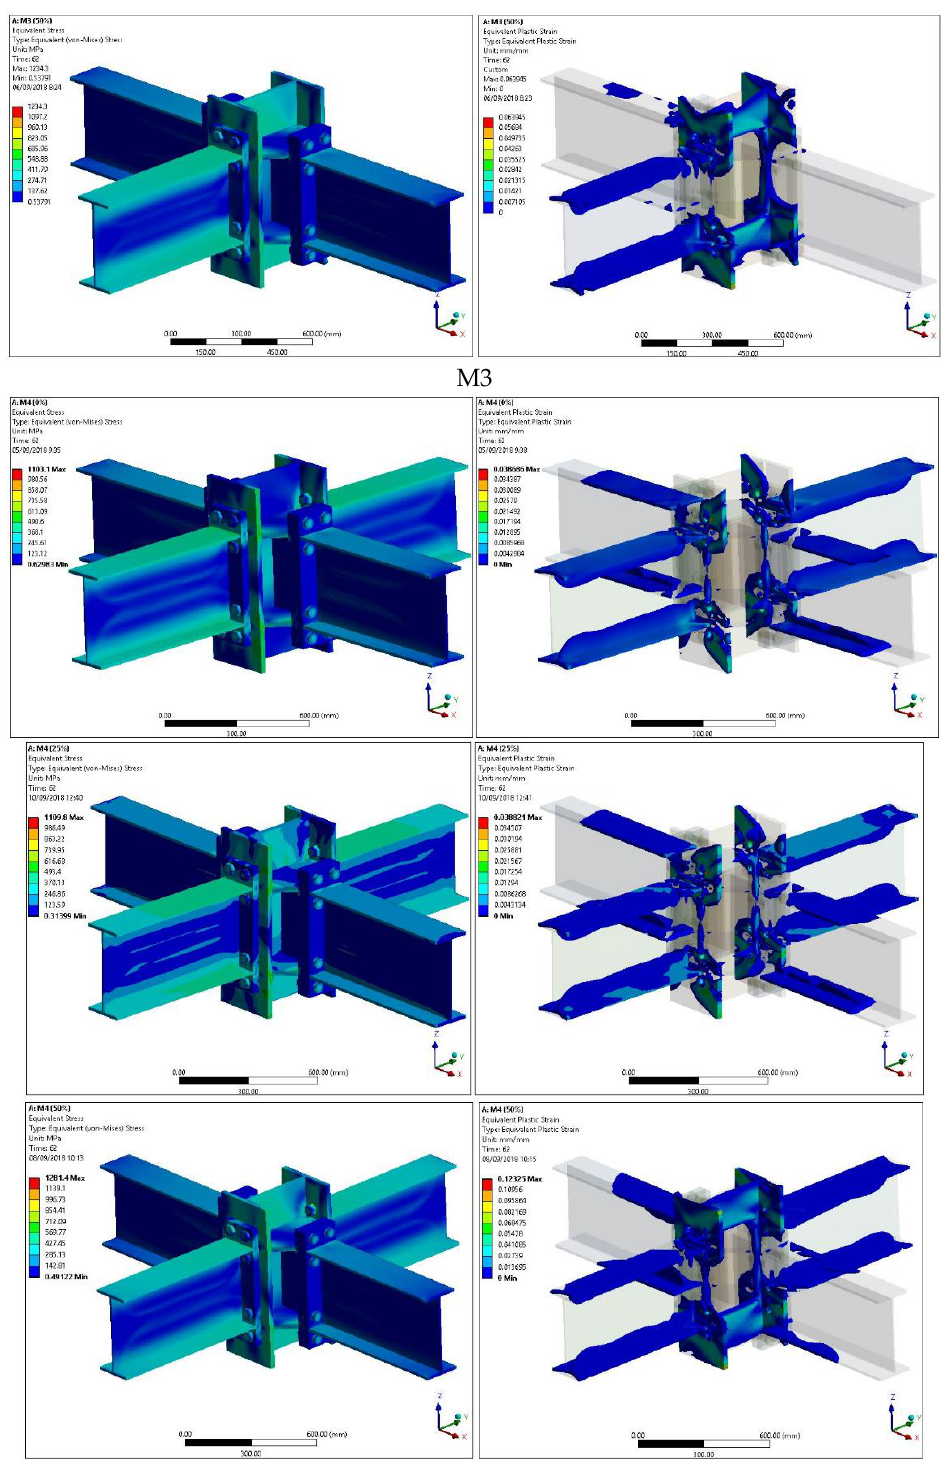
Figure 13. Distribution of von Mises stress and plastic strains by applied maximum displacement for the configurations studied ( M1, M2, M3 and M4